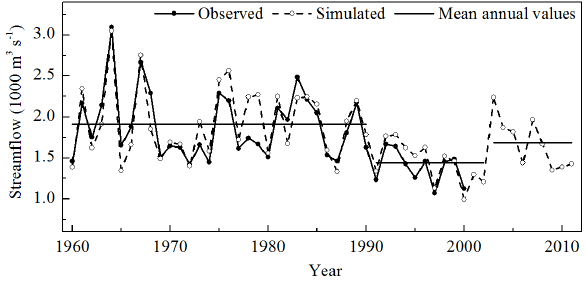
Fig. 4. SWAT-simulated annual natural streamflow at the Huayuankou station from 1960 to 2011. The horizontal lines show the SWAT-simulated mean annual streamflow in the baseline (1960– 1990), low-flow (1991–2002), and recent (2003–2011)